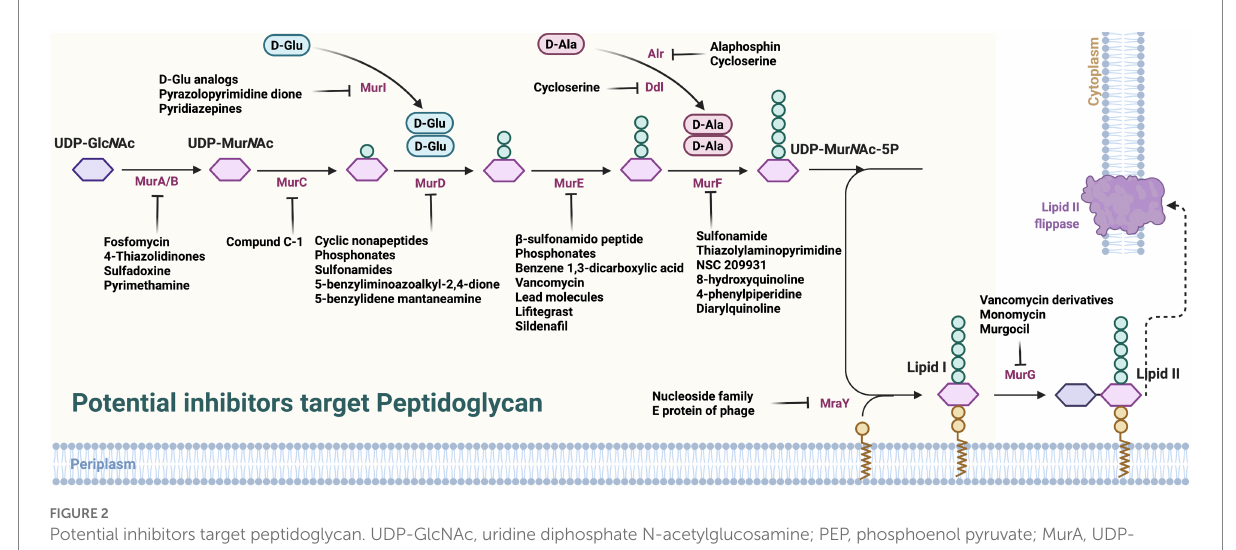
FIGURE 2 Potential inhibitors target peptidoglycan. UDP-GlcNAc, uridine diphosphate N-acetylglucosamine; PEP, phosphoenol pyruvate; MurA, UDP- GlcNAc enol pyruvate transferase; MurB, UDP-N-acetyl allylacetone glucosamine reductase; MurG, decadecenyl diphosphate-MurNAc- pentapeptide- UDP-GlcNAcGlcNAc transferase; MraY, UDP-MurNAc-pentapeptide phosphotransferase; PBP, penicillin-binding